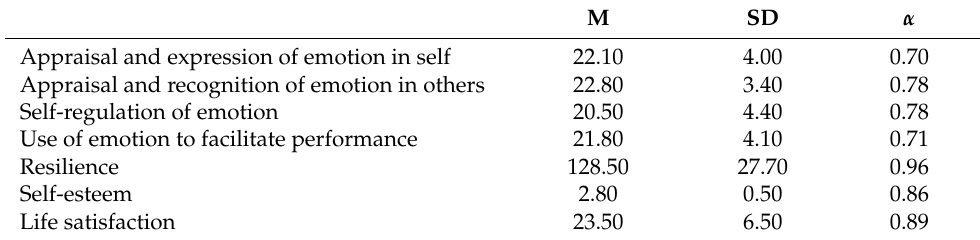
Table 1. Descriptive statistics and reliability.